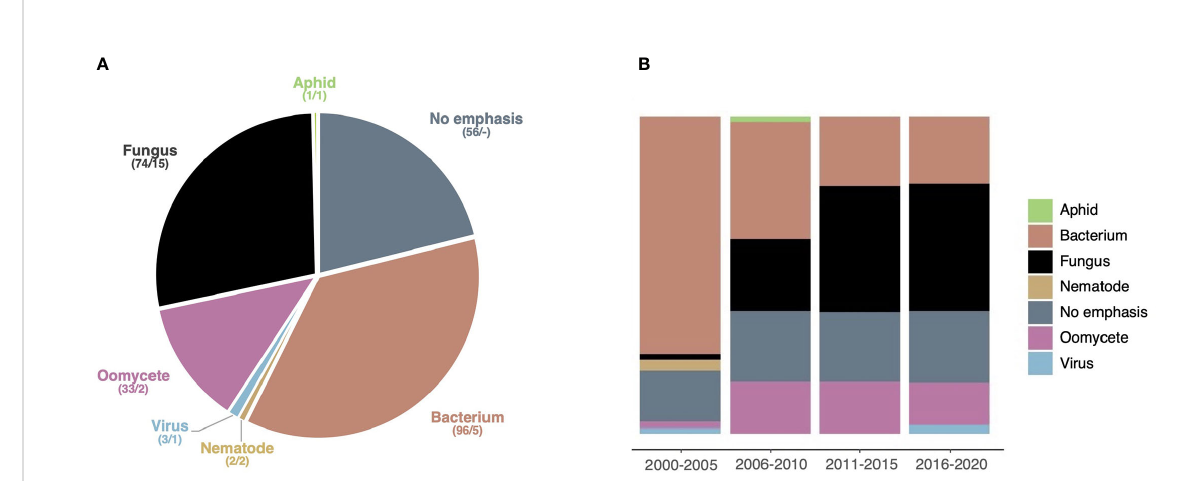
FIGURE 5 Studies emphasizing fungi gain importance over time. (A) Pie chart displaying the seven taxonomic groups of pathogens emphasized (if any) addressed by the HIPEs. The assignment of each HIPE was based on iterative expert reading of the publications. For each taxonomic group, the number of HIPEs and the total number of species are indicated ( e.g . ‘ 74/15 ’ ). (B) Percent stacked bar chart displaying the evolution of the relative size of taxonomic groups over one six-year time frame (low number of publications during this frame) and four fi ve-year time: 2000- 2005, 2006-2010, 2011-2015, and 2016-2020, respectively. Color code is the same as in (A) . The raw data used to build this fi gure are available in the Dataset